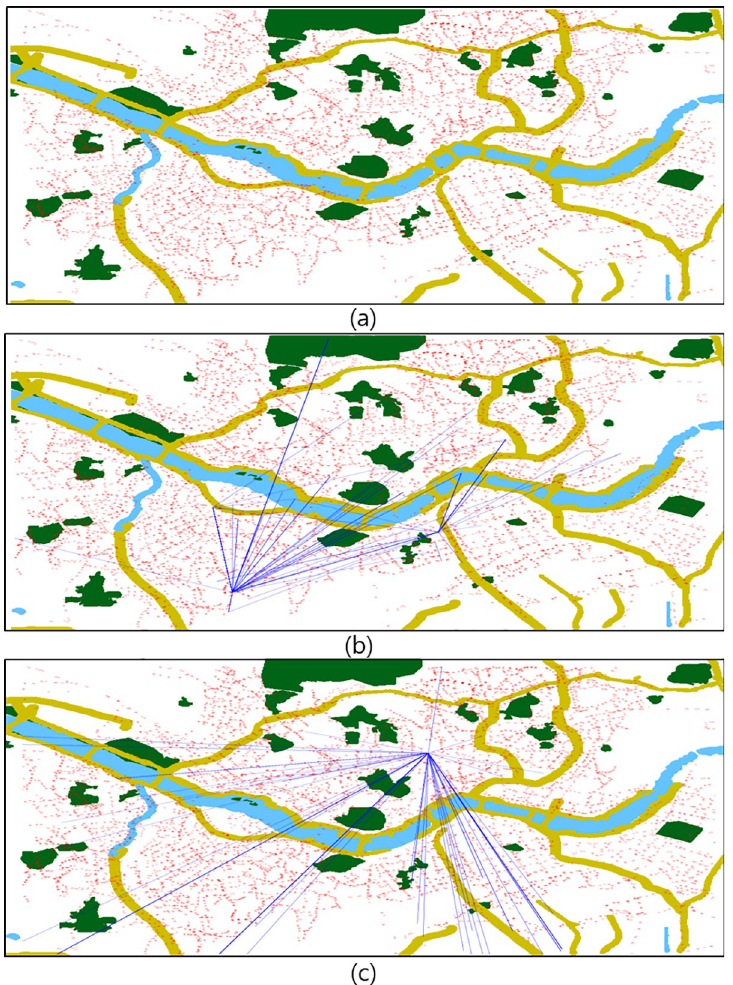
Fig 1. Maps representing the collected mobility data: (a) map with stations, (b) map with mobility data from one user, and (c) map with the mobility data from one station.